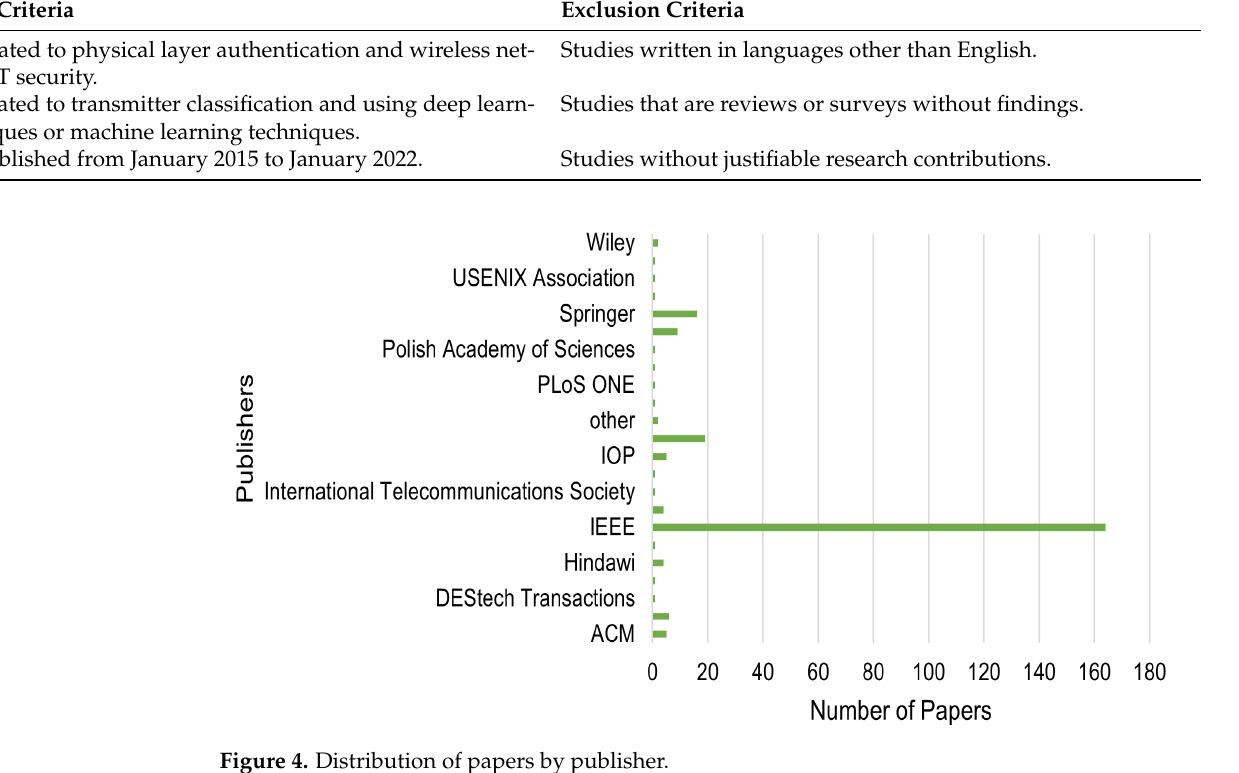
Figure 4. Distribution of papers by publisher.